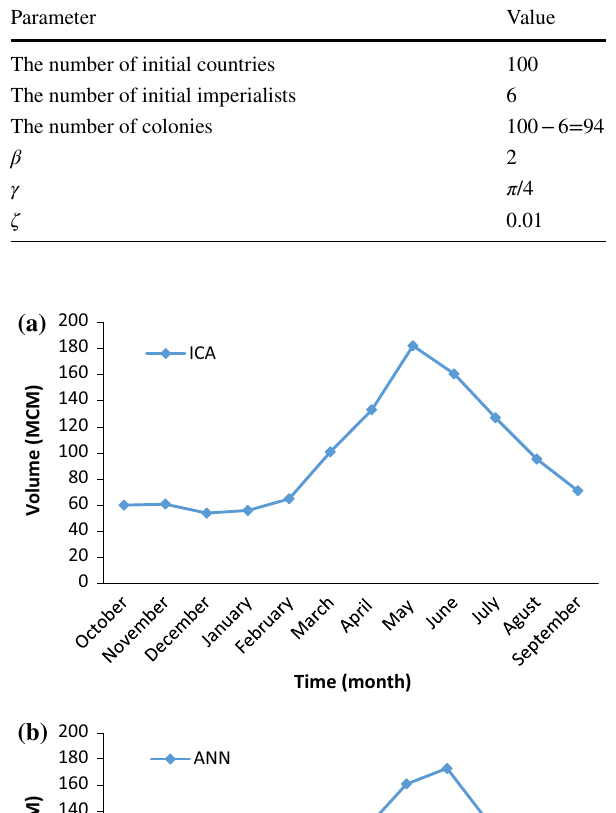
Table 6 The optimal values for parameters of ICA Parameter